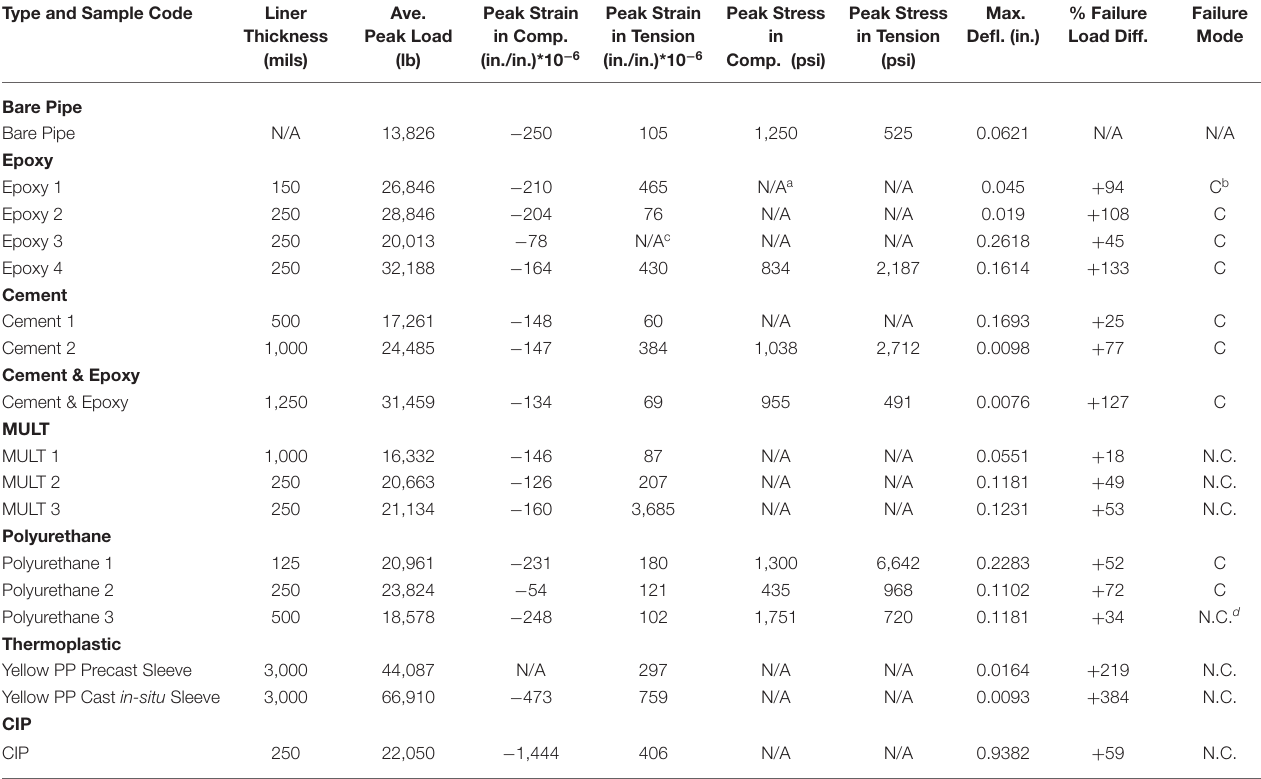
TABLE 2 | Summary of Test